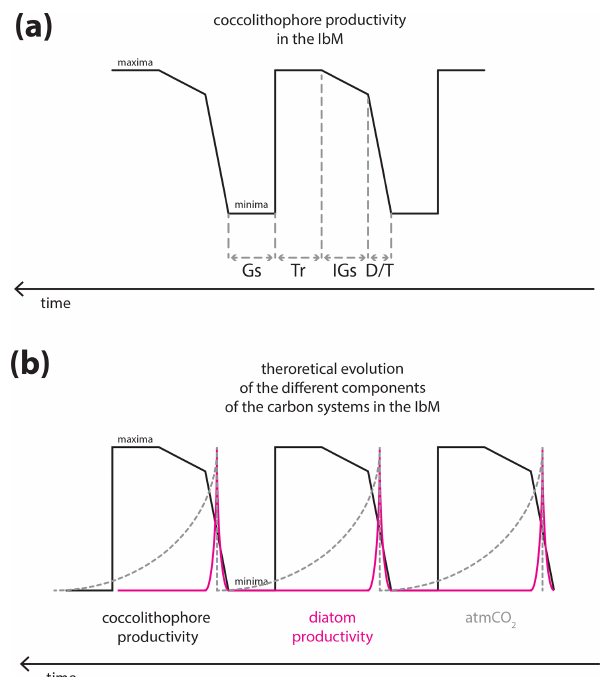
Figure 8. Theoretical curves of the carbon cycle components in the IbM: (a) hypothesized coccolithophore paleoproductivity for the IbM for the studied interval; (b) theoretical diatom productiv- ity behaviour, with the characteristic spike at terminations (Meckler et al., 2013) and atmCO 2 changes, with the characteristic sawtooth shape. Note that the intervals were drawn with no specific duration. Gs, Tr, IGs, and D / T stand for glacial substage, transition from in- terglacial to glacial substages, interglacial substages, and deglacia- tion/transition,